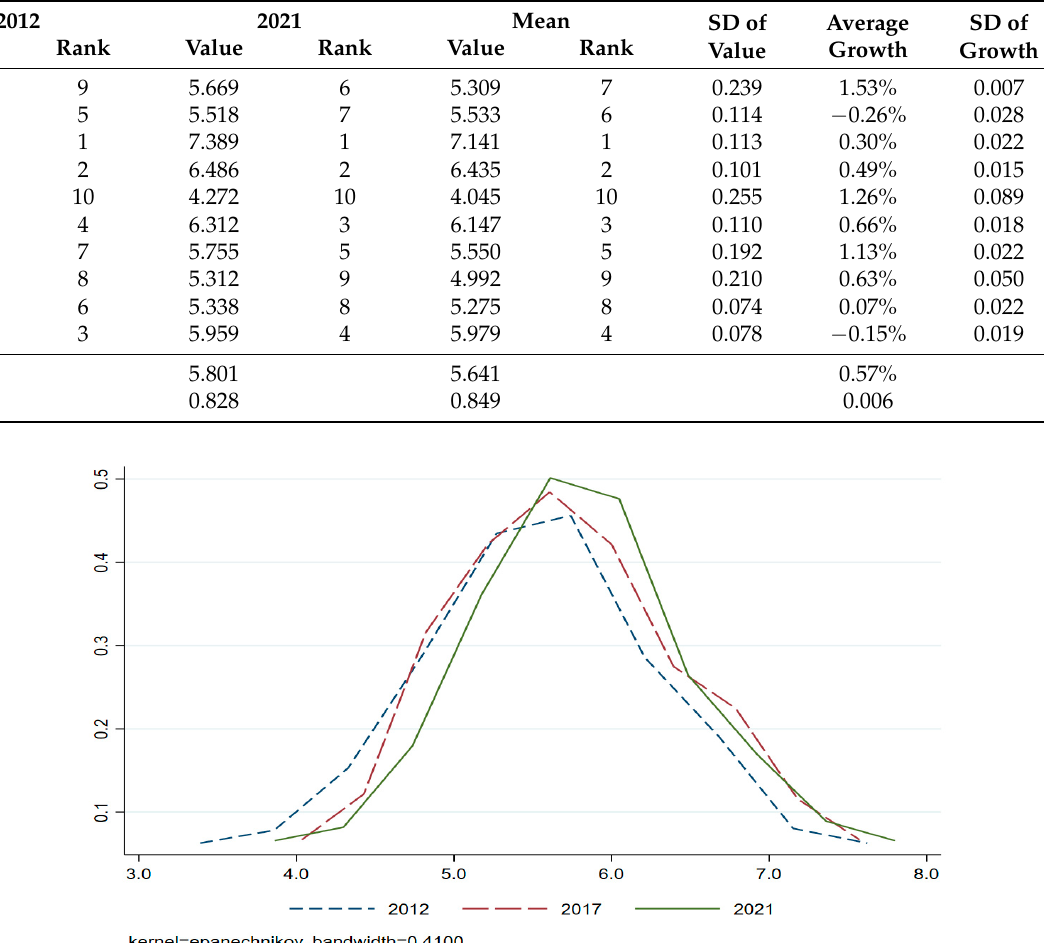
Table 5. The results of the international competitiveness of wooden furniture.